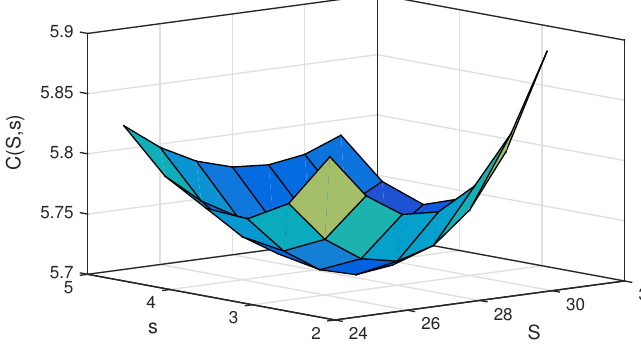
Figure 1. Total expected cost rate as a function of s and